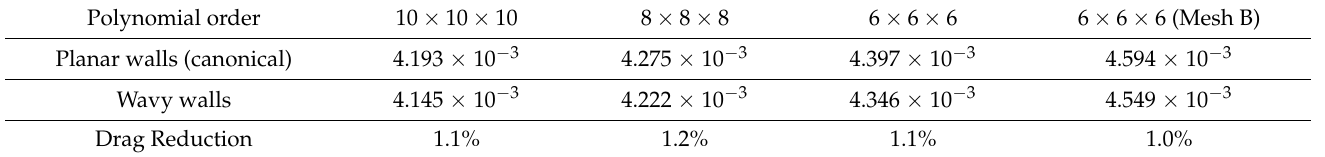
Table 2. DNS computations: drag prediction for canonical and wavy-walled turbulent channel flows. Polynomial